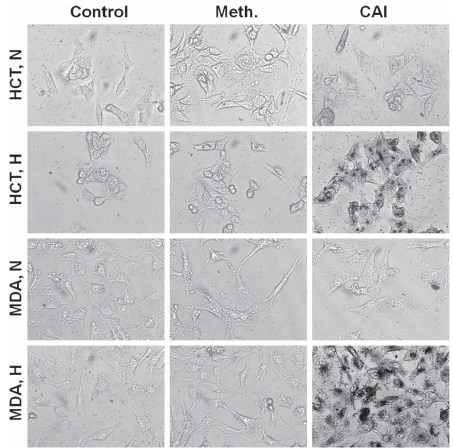
Figure 3. 350 µ m × 250 µ m Optical micrographs of HCT or MDA cells in normoxia (N) and hypoxia (H), Figure 3. 350 μm × 250 μm Optical micrographs of HCT or MDA cells in normoxia (N) and hypoxia treatedwithoutparticles(Control)orwith100 µ MofCAI-terminatedparticles 16 or2-methoxyethylamine- (H), treated without particles (Control) or with 100 μM of CAI-terminated particles 16 or (Meth.) 17 and finally stained with silver 2-methoxyethylamine- (Meth.) 17 and finally stained with silver [21].